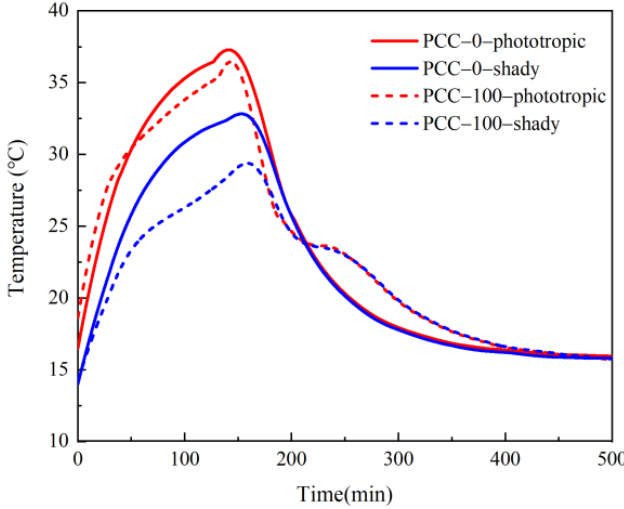
Figure 15. The curve of the center temperature of the inner and outer surfaces of concrete slabs. The temperature change of phase change aggregate concrete presents relatively com- plex fluctuations because the paraffin inside the aggregate has phase change in both the heating and cooling stages, which affects the heat transfer in the direction of the temper- ature gradient. The addition of PCM leads to the difference in the temperature variation pattern of concrete. During the heating process, paraffin stores heat through a phase change, resulting in a slow temperature rise. At the same time, the temperature of phase change concrete is always lower than that of basalt concrete, and the final temperature is also lower. which delays the temperature reduction process of the phase change concrete